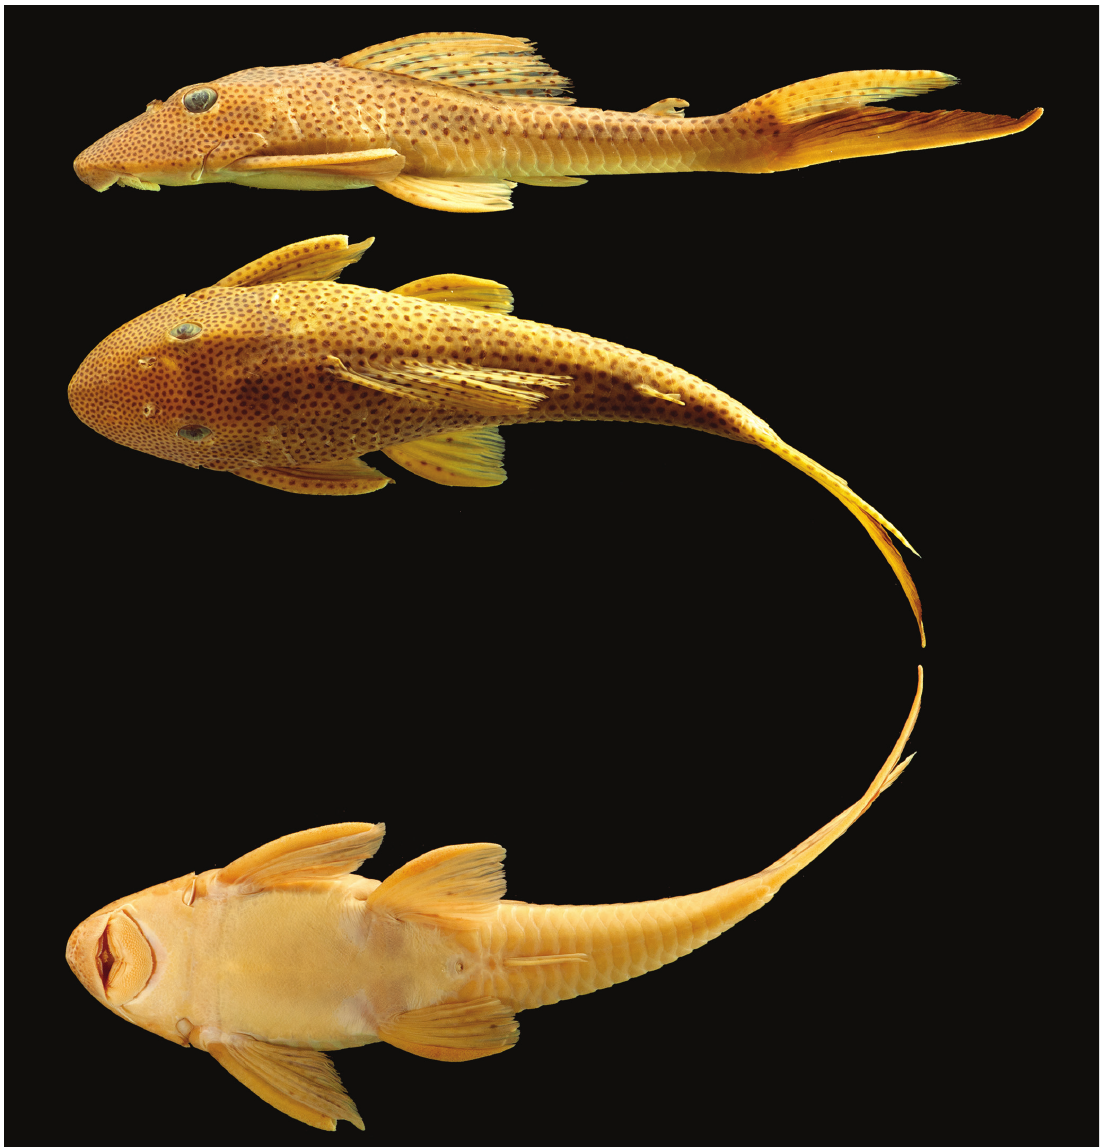
Fig. 1. Holotype of Aphanotorulus rubrocauda , INPA 33666, 150.5 mm SL, Brazil, Amazonas State, Apuí Municipality, Resex do Guariba, rio Aripuanã drainage, tributary of the rio Madeira basin, in lateral, dorsal, and ventral views.